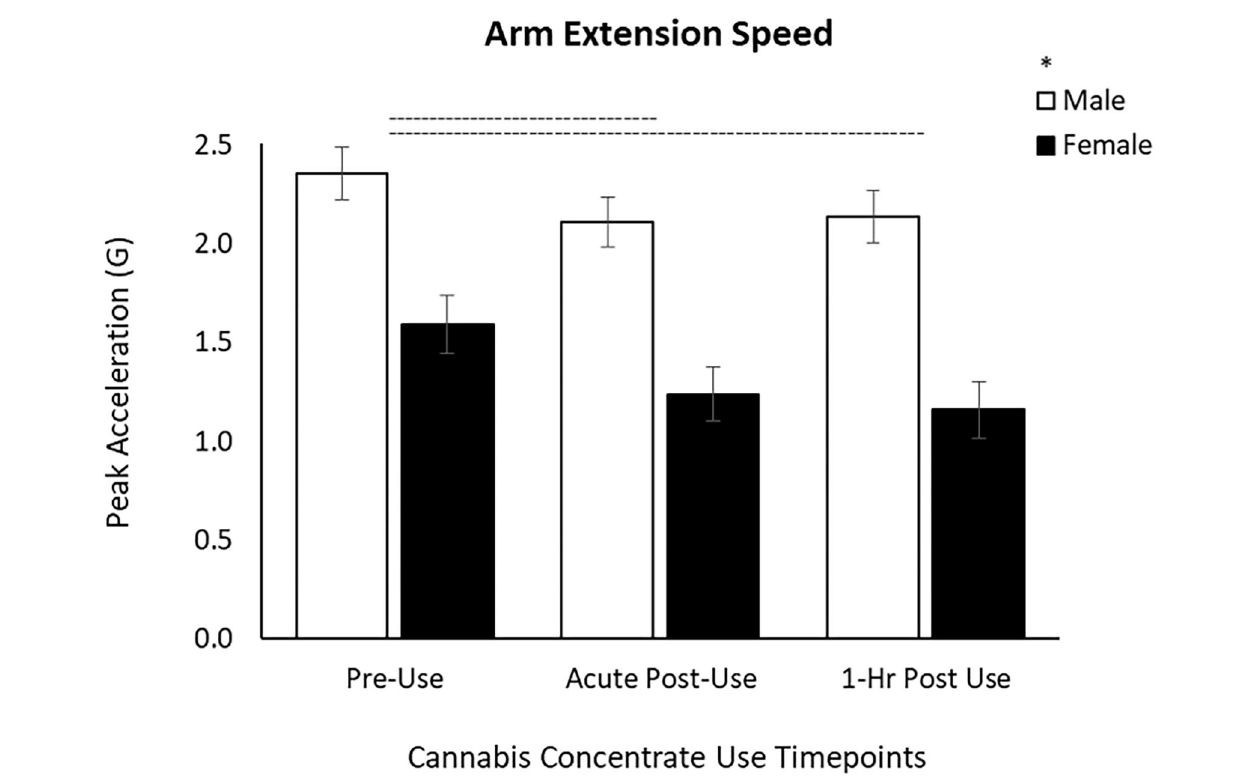
FIGURE 2 | Arm extension speed decreases by 15% after concentrate use from Pre-Use to Acute Post-Use and by 16% and from Pre-Use to 1h Post-Use in male and female users. Male arm extension speed is greater than females, yet the response to cannabis concentrate is similar between sexes (no Time x Sex interaction). (–) Main Time effect followed by pairwise comparisons denoted between timepoints; (*) Main Sex effect denoted above key ( p < 0.05).